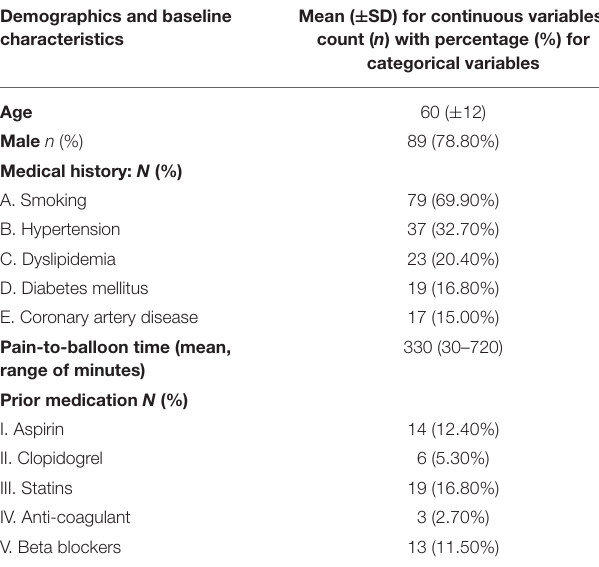
TABLE 2 | Demographics and baseline characteristics. Demographics and baseline characteristics